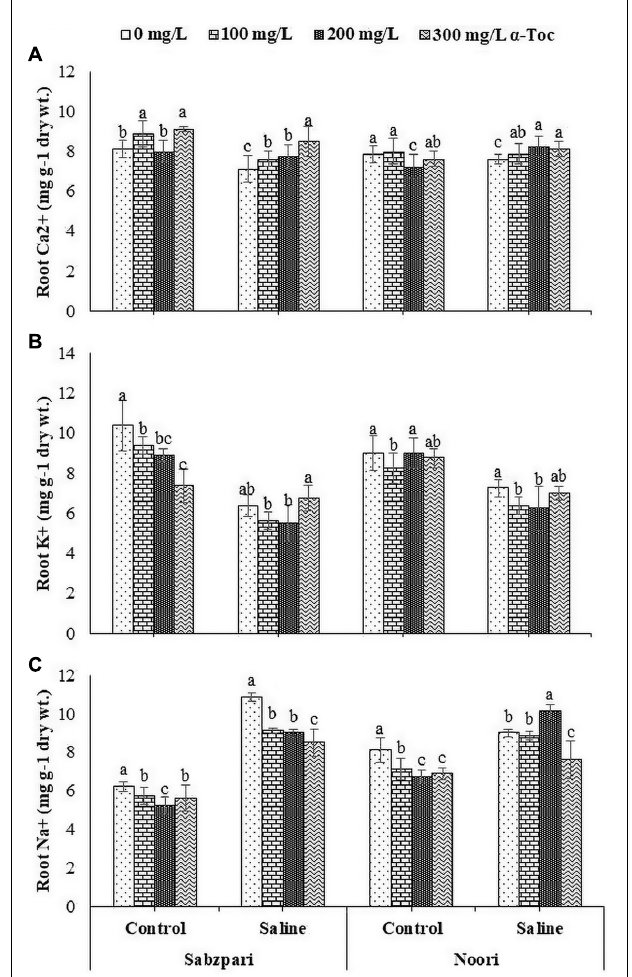
FIGURE 8 | Root Ca 2 + (A) , Root K + (B) Root Na + (C) of okra varieties sprayed with different levels of α -tocopherol under saline conditions. Values represent means ± S.D. Significant differences among row spacing were measured by the least significant difference (LSD) at p > 0.05 and indicated by different